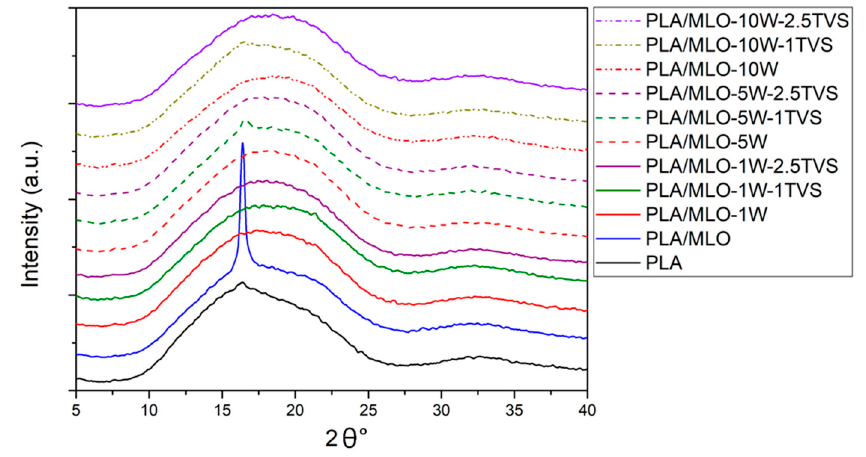
Figure 8. XRD patterns of the formulated materials.